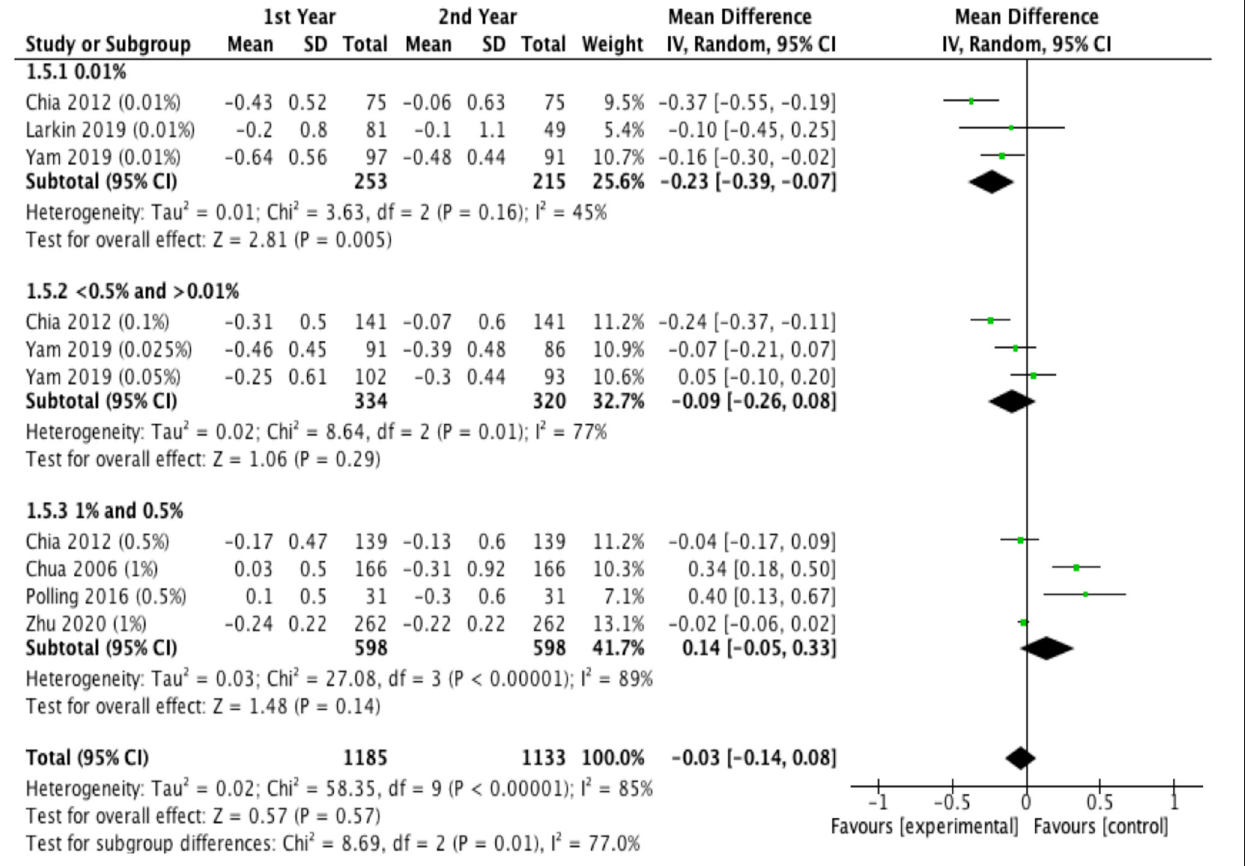
FIGURE 5 | Effects of different doses of atropine on refraction changes in the first and second years of treatment (diopters/year).